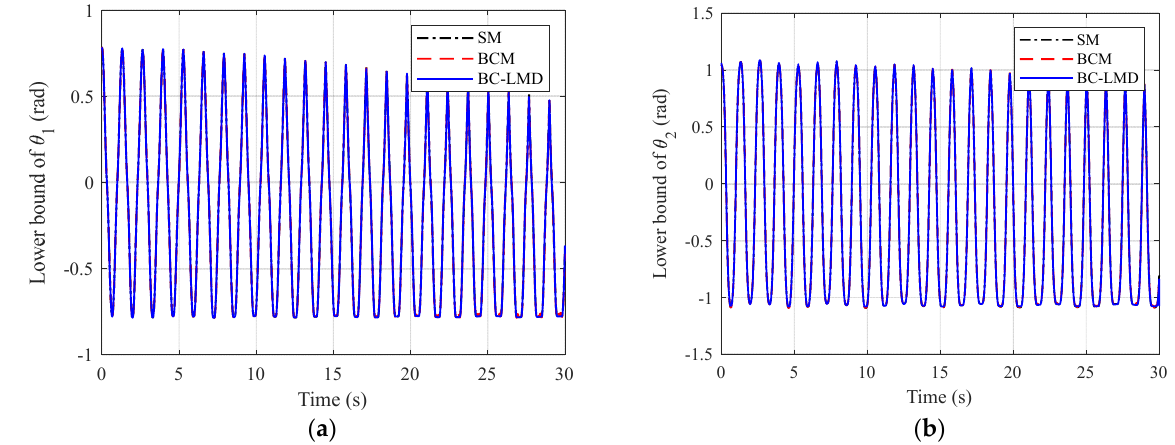
14 of 17 Figure 11. Schematic of the double pendulum. Table 2. Parameter of the double pendulum. Parameters Value (Unit) Length of top rod ( L 1 ) 0.2 (m) Length of bottom rod ( L 2 ) 0.3 (m) Mass of top rod ( m 1 ) 1 (kg) Mass of bottom rod ( m 2 ) 1 (kg) Gravitational acceleration ( g ) 9.81 (m/s 2 ) Regard L 1 , L 2 , and g as interval parameters, and their values are [0.198, 0.202] m, [0.297, 0.303] m, and [9.790, 9.809] m/s 2 , respectively. In this case, the uncertainty levels